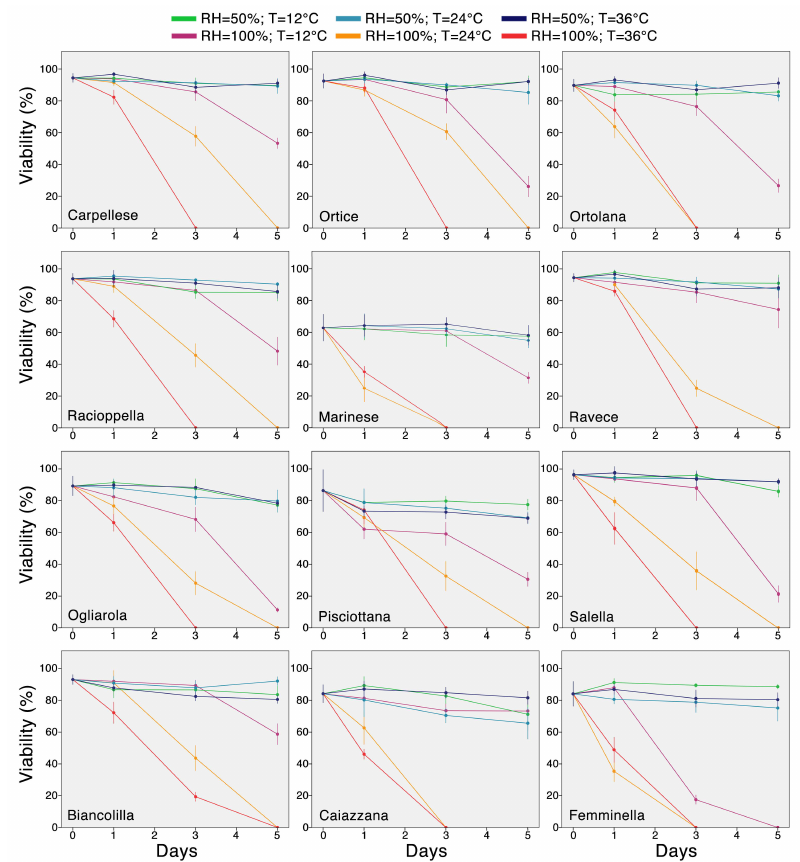
Figure 4. Viability of pollen from 12 olive cultivars incubated at six different combinations of temperature and humidity for 5 days (T 1 –T 5 ) from sampling (T 0 ). Each line shows the mean ± SE ( n =